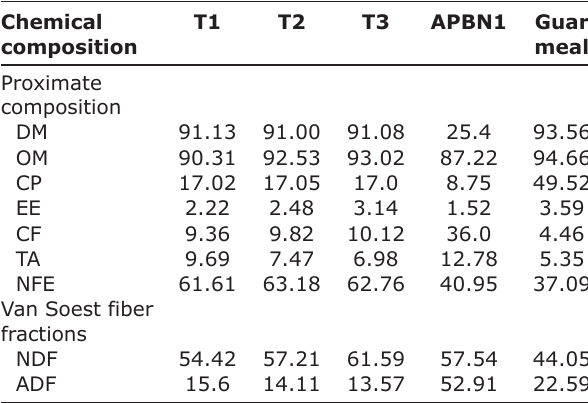
Table-2: Chemical composition of experimental rations (% DM basis)*, roughage and guar